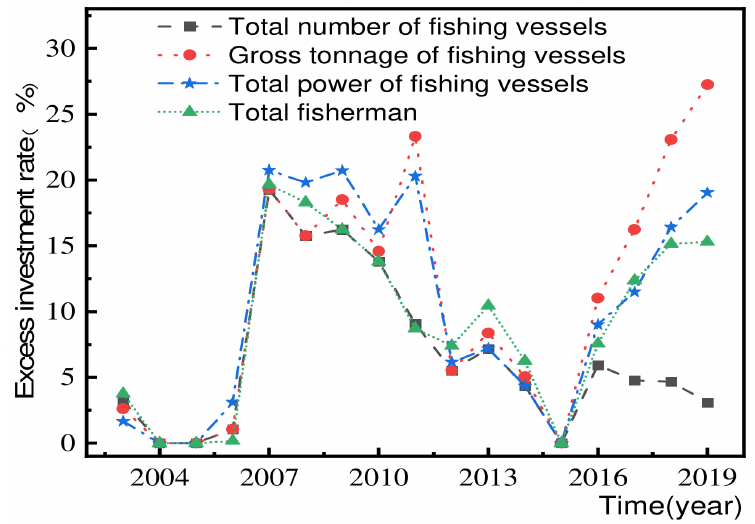
Figure 3. The fluctuation of excess investment rate from 2003 to 2019.